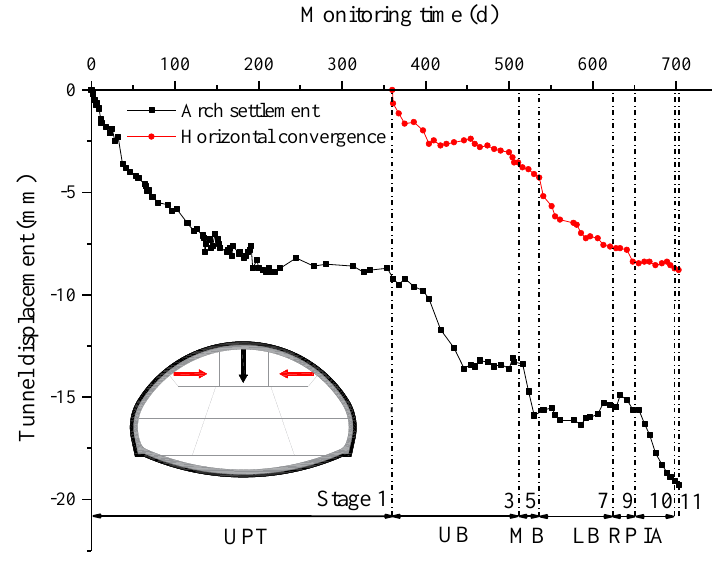
Figure 12. Curves of the tunnel displacement over time.